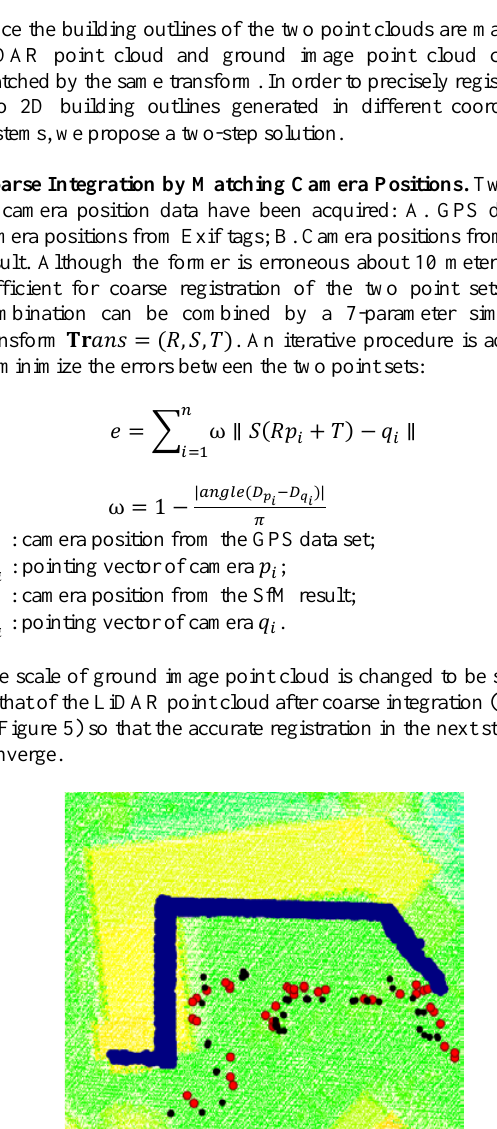
Figure 5. Coarse integration of LiDAR point cloud (elevation coloured in the background) and ground image point cloud (blue dots) by matching camera positions respectively from SfM (black dots) result and GPS data (red dots).